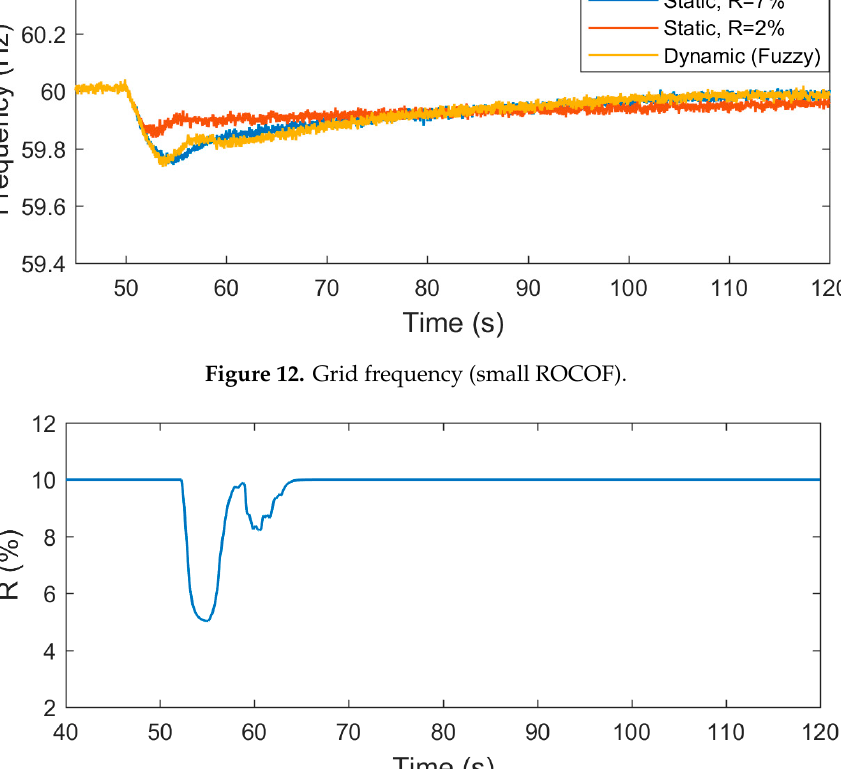
Figure 12. Grid frequency (small ROCOF).